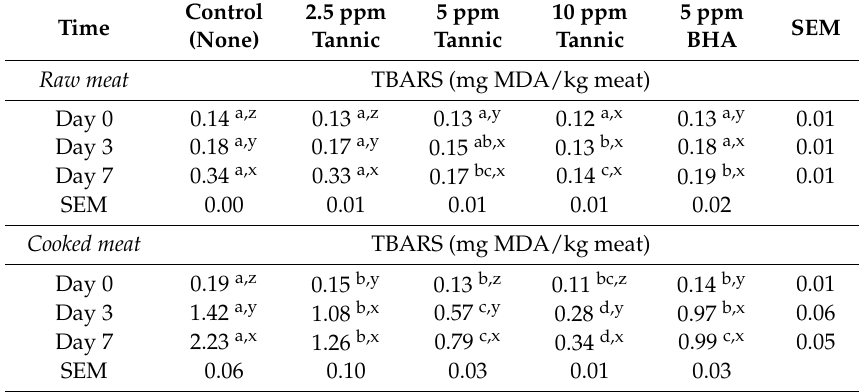
Table 1. 2-Thiobarbituric acid-reactive substances (TBARS) values of raw and cooked chicken breast meat with different levels of tannic acid during storage at 4 ˝